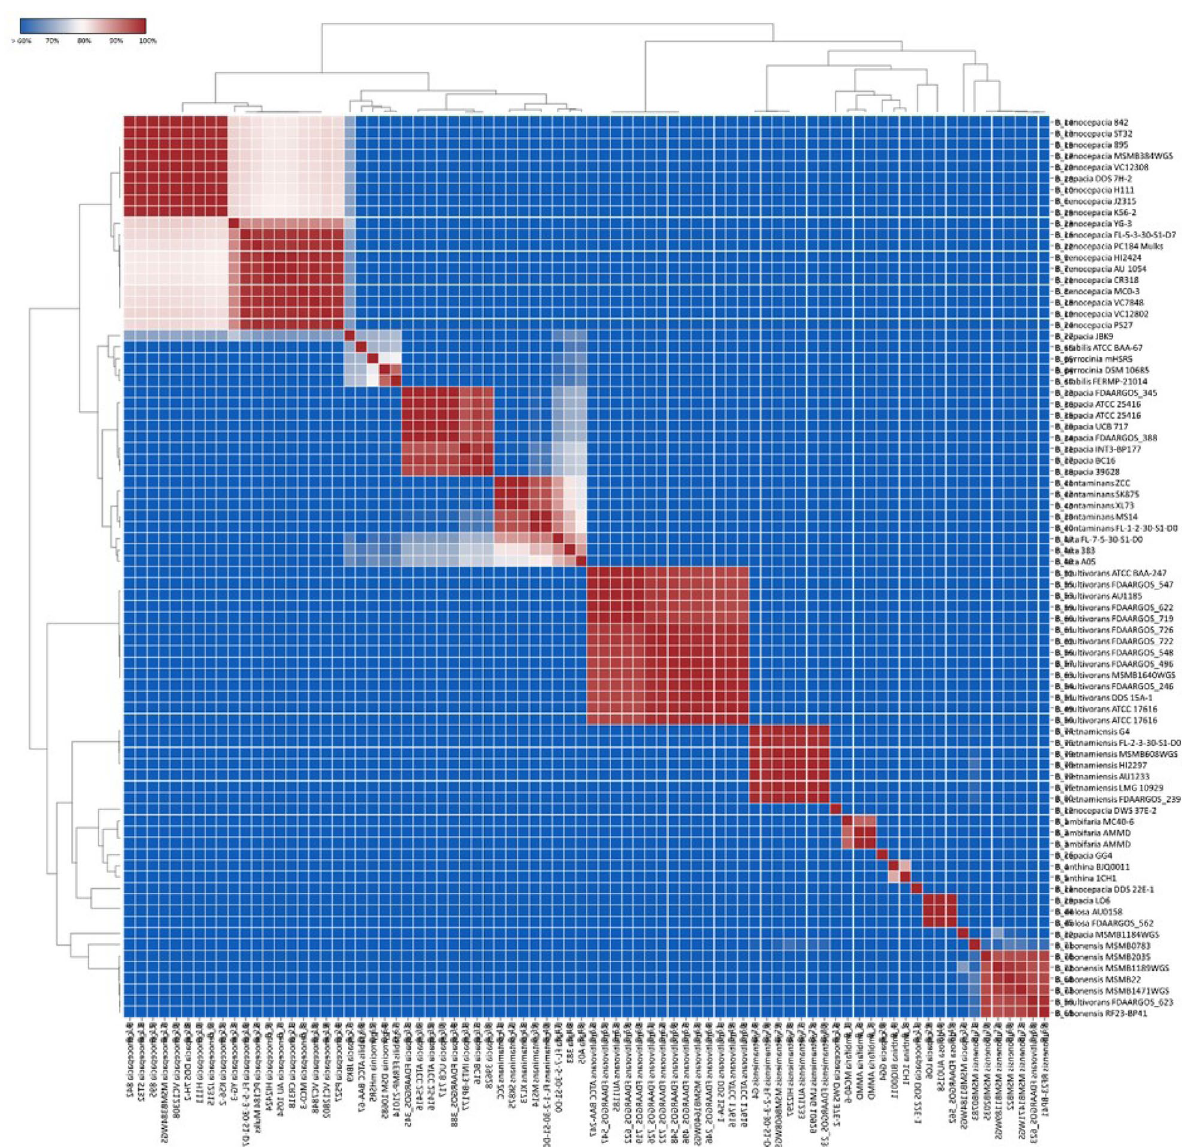
Fig. 1 Clustering of 80 Burkholderia genome sequences on the basis of average nucleotide identity (ANI). Heatmap shows the level of sequence similarity on the scale 60 to 100 where > 60% similarity is depicted in blue and 100% similarity is depicted in